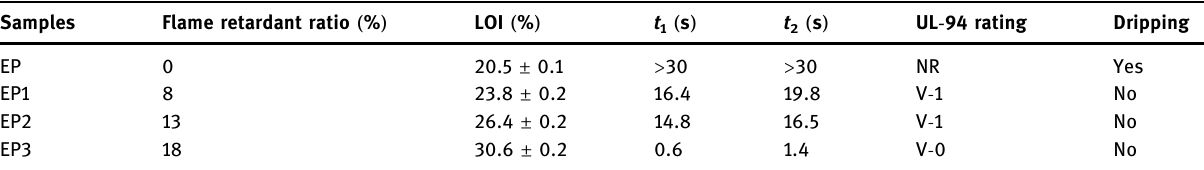
Table 3: LOI and UL - 94 test results for fl ame retarded EP Samples